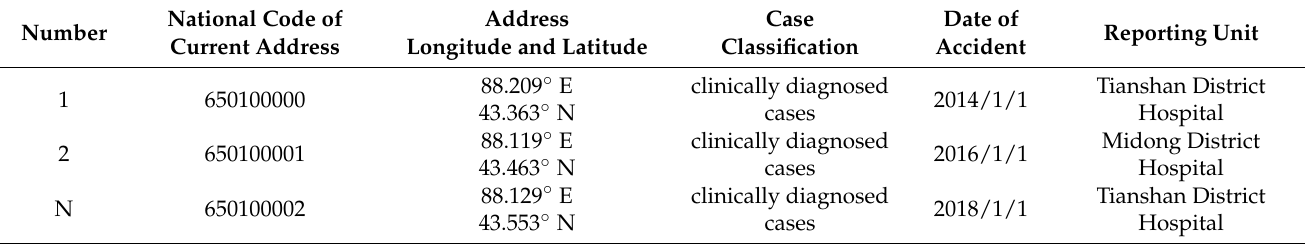
Table 1. Sample data of